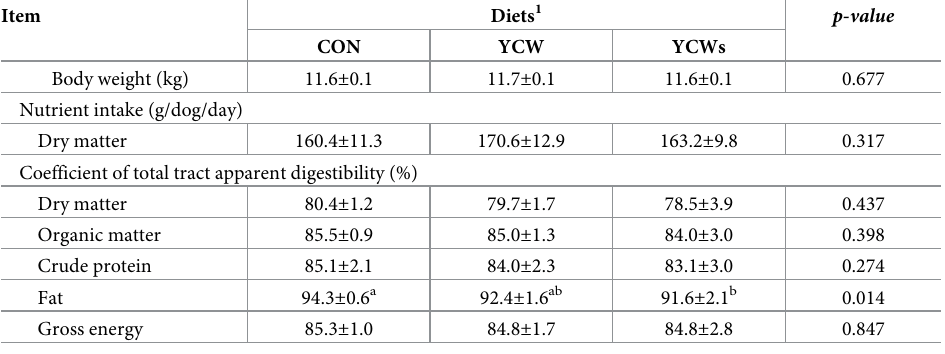
Table 3. Body weight (kg), nutrient intake (g/dog/day) and coefficients of total tract apparent digestibility (%) of nutrients of diets for dogs with the additions of different yeast cell wall preparations (mean and standard error of the